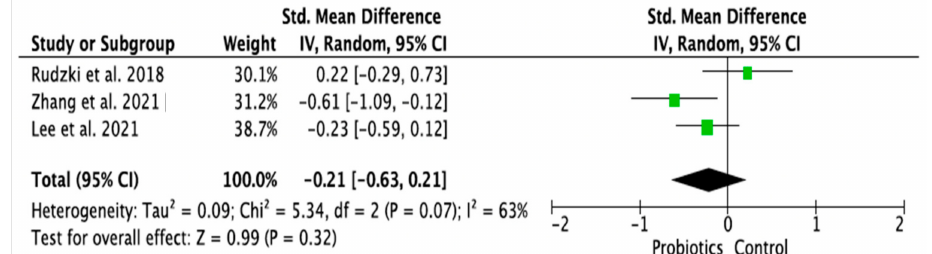
Figure 8. Forest plot for the effect of probiotic treatment on IL-6 level in probiotics and control groups [21,28,33]. Note: The green squares are the SMD for the post-hoc studies, the black rhombus is the graphical summary for all studies above.